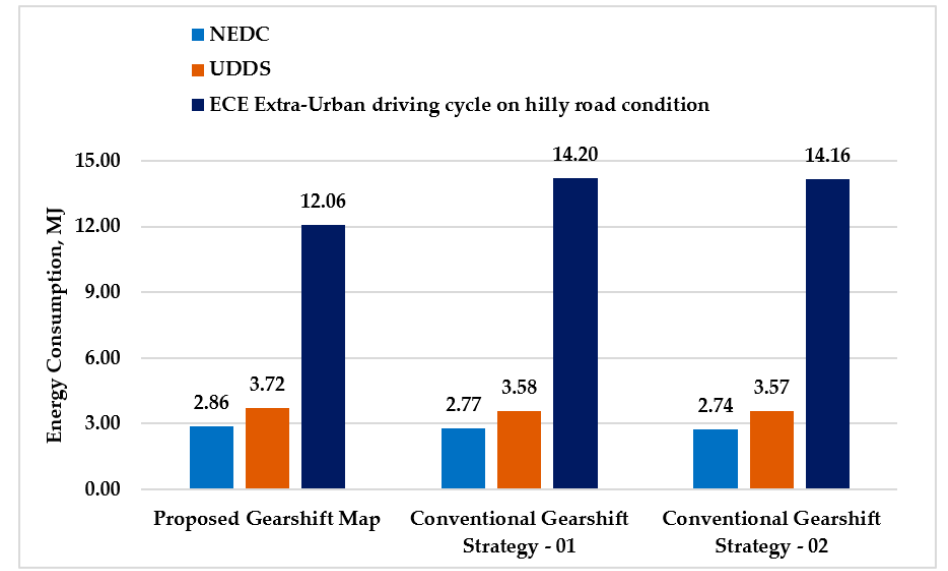
Figure 18. Comparison of energy consumption between proposed and conventional gearshift strategies.